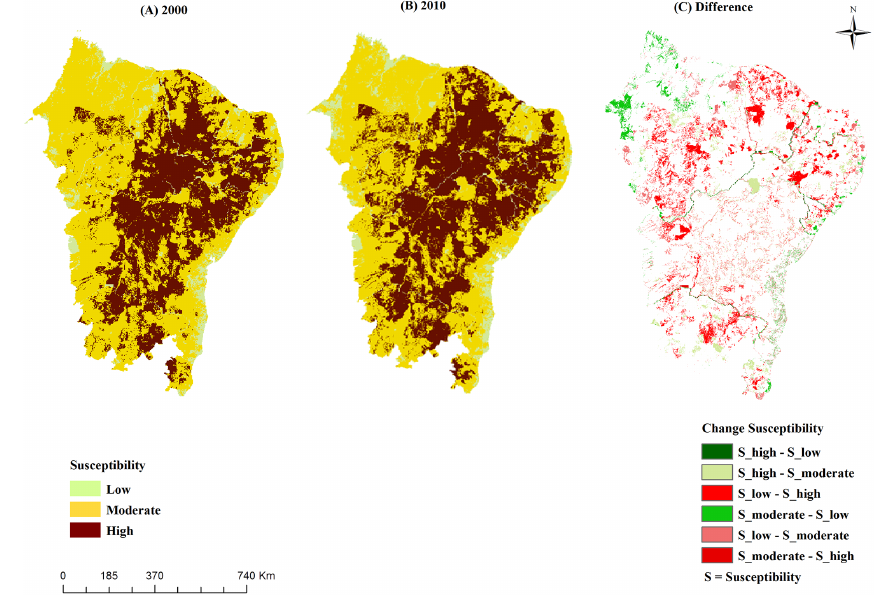
Figure 4. Environmental susceptibility area for (a) 2000 and (b) 2010. (c) Difference between 2000 and 2010. Table 7. Percentage of the land area covered by each susceptibility class of the four quality indices in 2000 and 2010. Index Susceptibility class 2000 (%) Physical land quality index